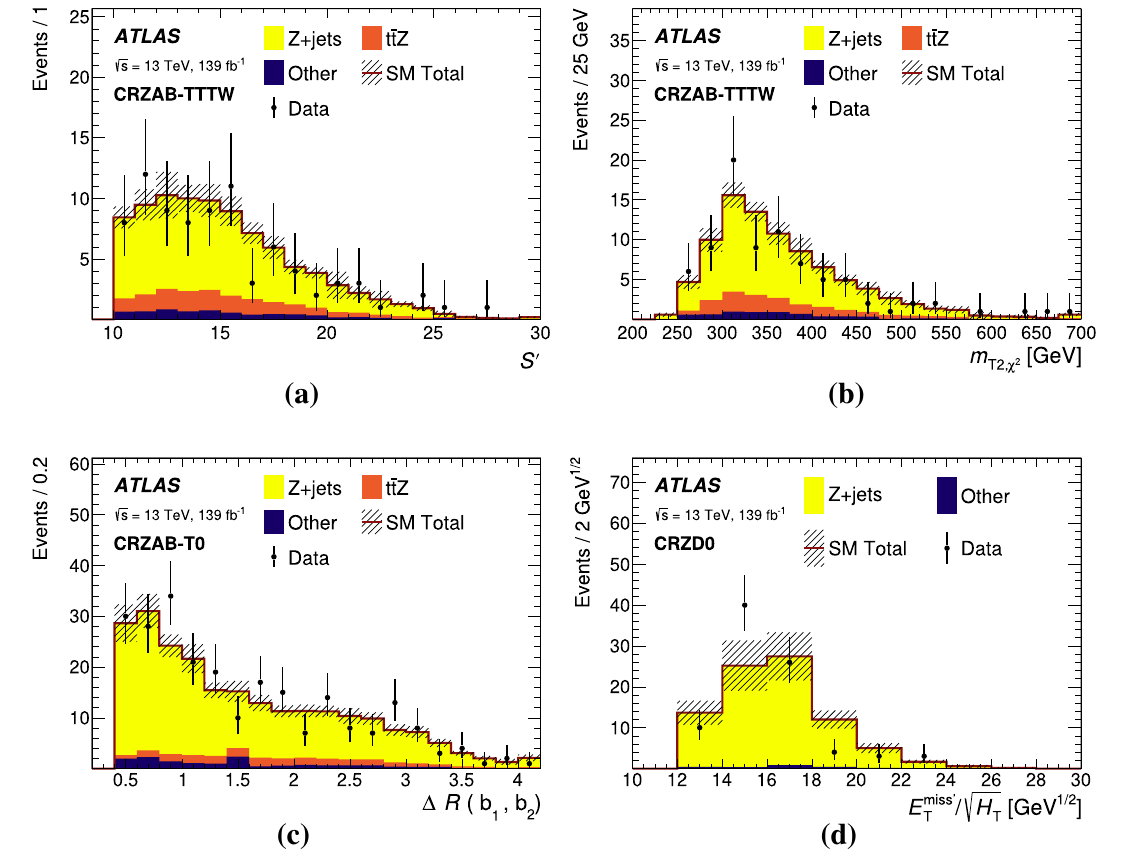
√ / H T for CRZD0. The hatched uncertainty band around the SM E miss (cid:7) T expectation includes the combination of MC statistical, theory-related and detector-related systematic uncertainties. The rightmost bin in each plot includes all